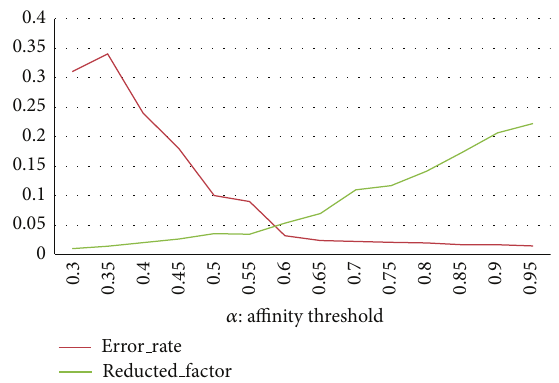
Figure 9: Accuracy of TTC across different numbers of